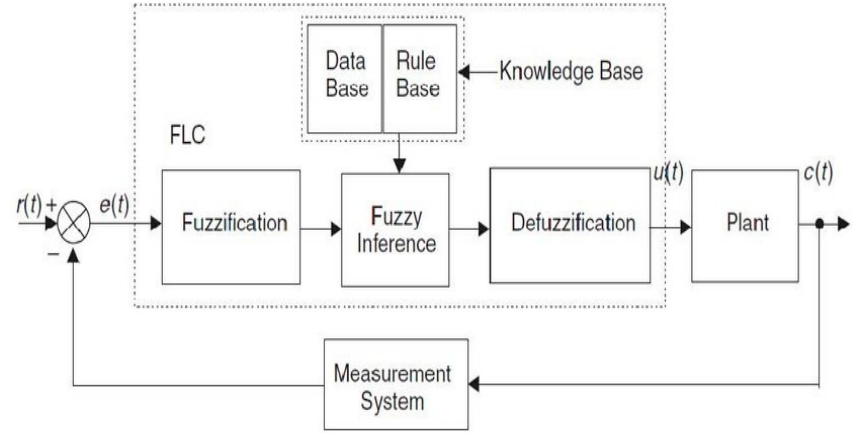
Figure 11. Fuzzy logic control basic structure.